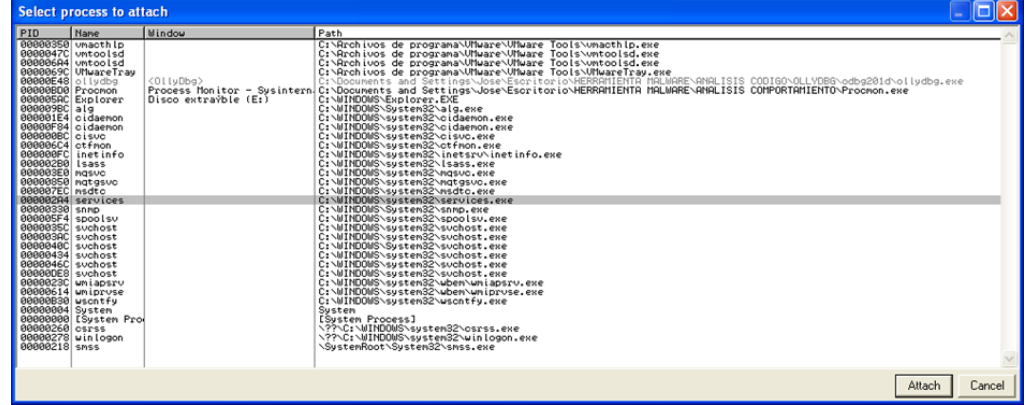
Figure 16. OllyDbg—list of processes.